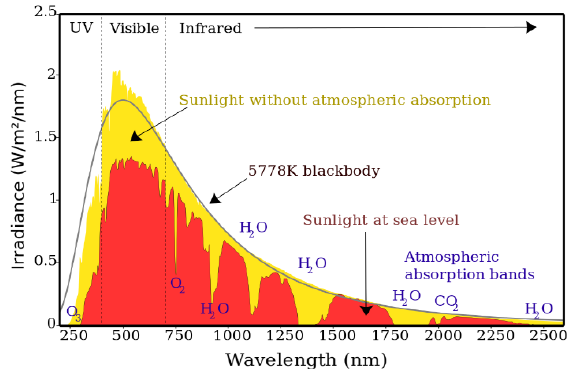
Figure 1. Real-time direct light solar radiation spectrum for atmosphere and sea level.